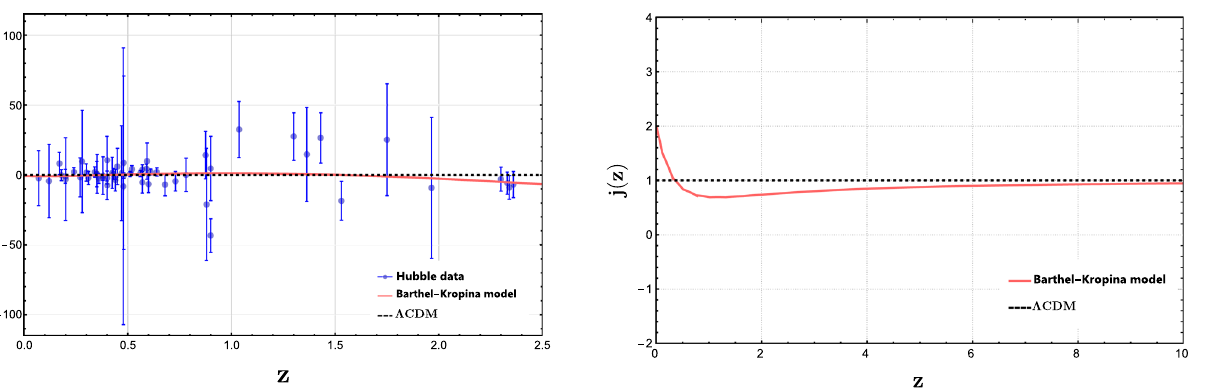
Fig. 6 Evolution of the jerk parameter as a function of the redshift z for the Barthel–Kropina and (cid:2) CDM cosmological models